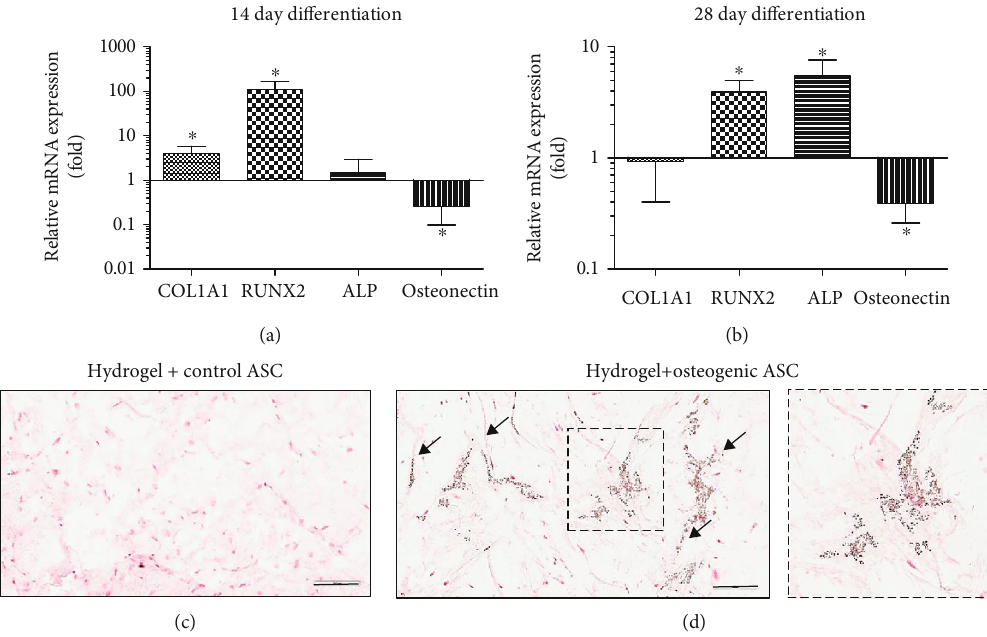
Figure 4: Analysis of osteogenic di ff erentiation of ASCs in DAT hydrogel. ASC seeded DAT hydrogels (2 × 10 6 cells/mL) were cultured in stromal or osteogenic media for 14 or 28 days and analyzed by qRT-PCR (a, b) and Von Kossa staining (c, d). (a, b) Expression of osteogenic genes in osteoegnically induced ASC samples after 14 (a) or 28 days (b) of culture is displayed as fold change relative to the control ASC samples. (c, d) Representative images of Von Kossa stained histological sections of Control ASC (c) and osteogenic ASC (d) seeded hydrogels. (d) Mineral deposits (brown) are indicated by arrows. Data are expressed as mean ( n = 6 ) ± SD; level of signi fi cance: ( ∗ ) p < 0 : 05 ; Scale bar 200 μ